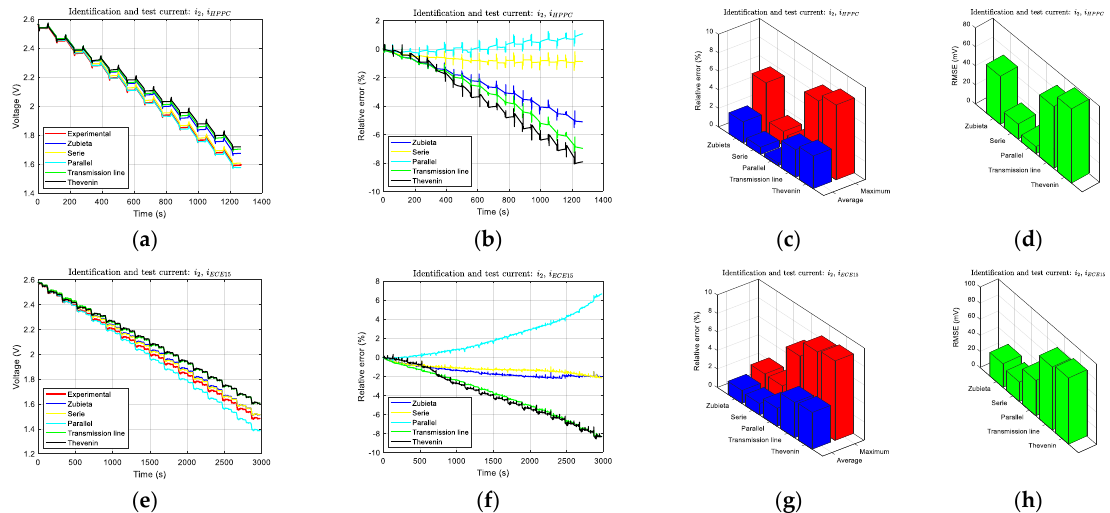
Figure 12. Experimental data and supercapacitor models time response, relative error (%), RMS error (mV): ( a ) – ( d ) current profile HPPC for i 2 , ( e ) – ( h ) current profile ECE15 for i 2 .